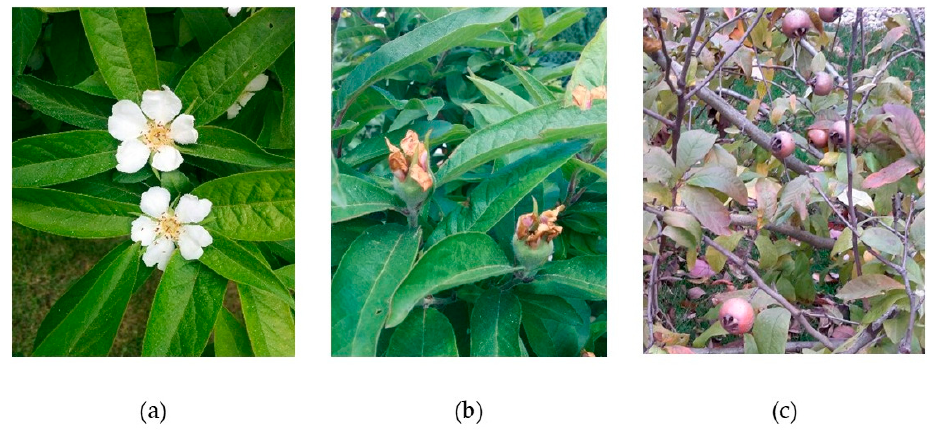
Figure 1. Flowers of medlar ( a ), fruit buds ( b ), fruit ready for harvesting ( c